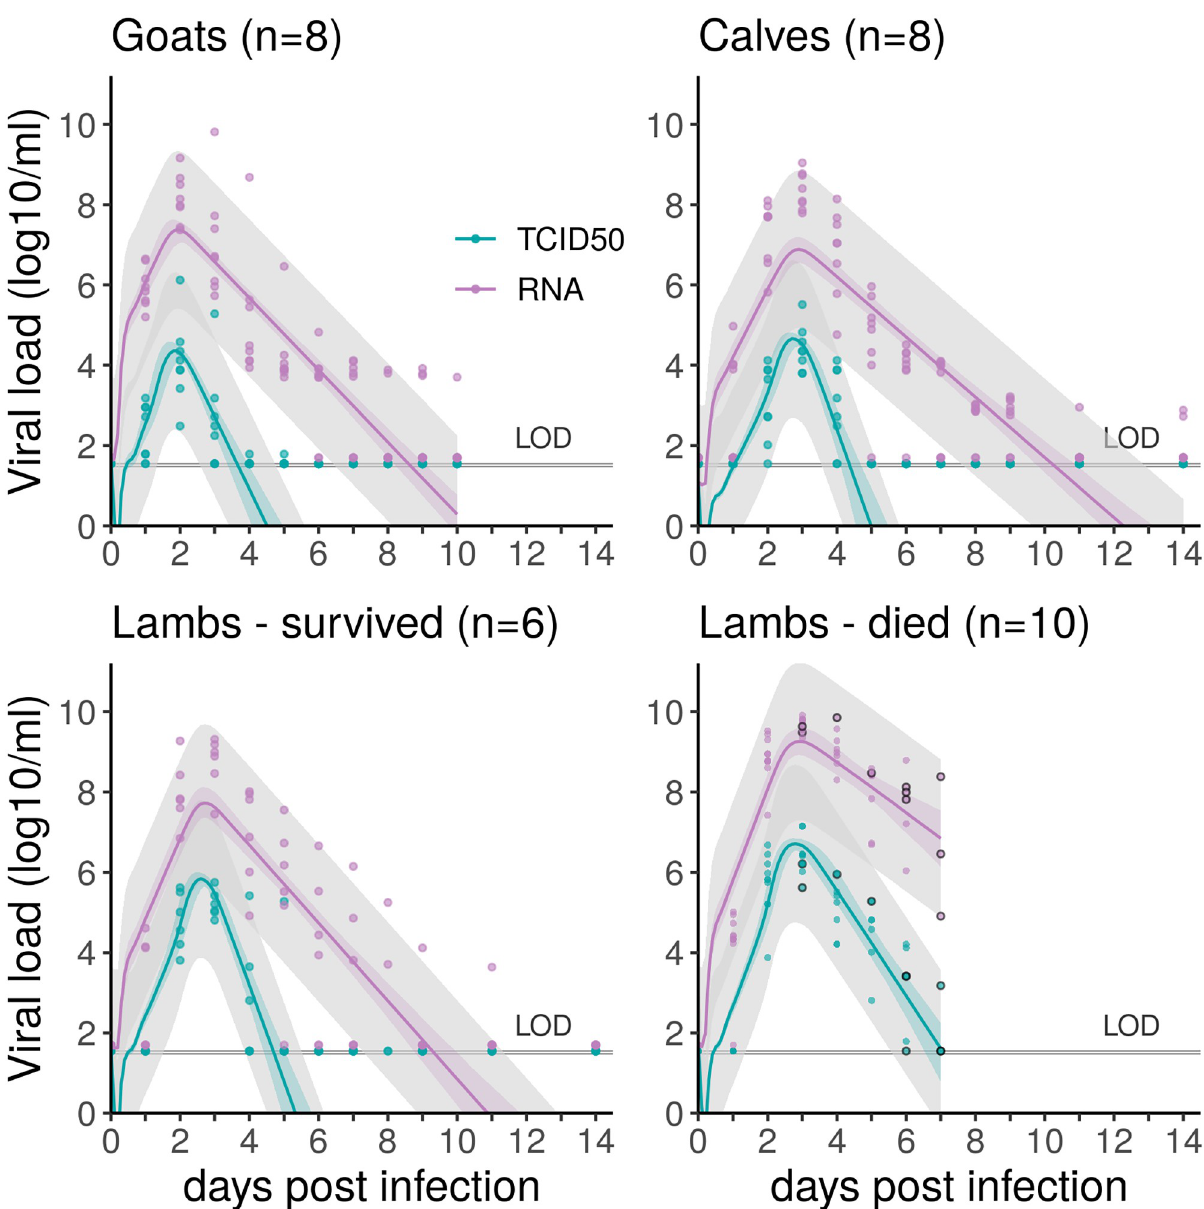
Fig 2. Data on viral RNA (RT-qPCR) and infectious virus (TCID 50 ), in log 10 /ml of plasma, and model fits, for host groups showing significantly different viral dynamics. Circles are data points. Solid colored lines show the median fit, obtained from 1000 posterior draws. Inner envelopes using the same colors shows the uncertainty from the parameter estimation process (quantiles [2.5–97.5]% of these posterior draws). Outer grey envelopes show the 95% uncertainty bounds associated with the observation process. We assumed this to be normally distributed with a standard deviation of 1 (log10 scale), in line with the sampling error. Purple is for viral RNA and blue for infectious viruses. For lambs which died from RVF, circled points represent individuals’ time of death. LOD = limit of detection, 1.55 for TCID 50 , 1.7 for viral RNA (log 10 ). rates in vectors (Materials and methods, Section S.2.1 in S1 Text). Selected experiments were performed with hamster hosts, Aedes or Culex spp. vectors, using RVFV strain ZH501. Dose-response curves differ significantly between Aedes and Culex spp. (Fig 4, Section S.2 in S1 Text). At 5 log TCID /ml for instance, which most animals could reach or exceed (Fig 10 50 2), there is 25% [17; 37] probability to infect an Aedes spp. vector and 11% [7; 18] probability